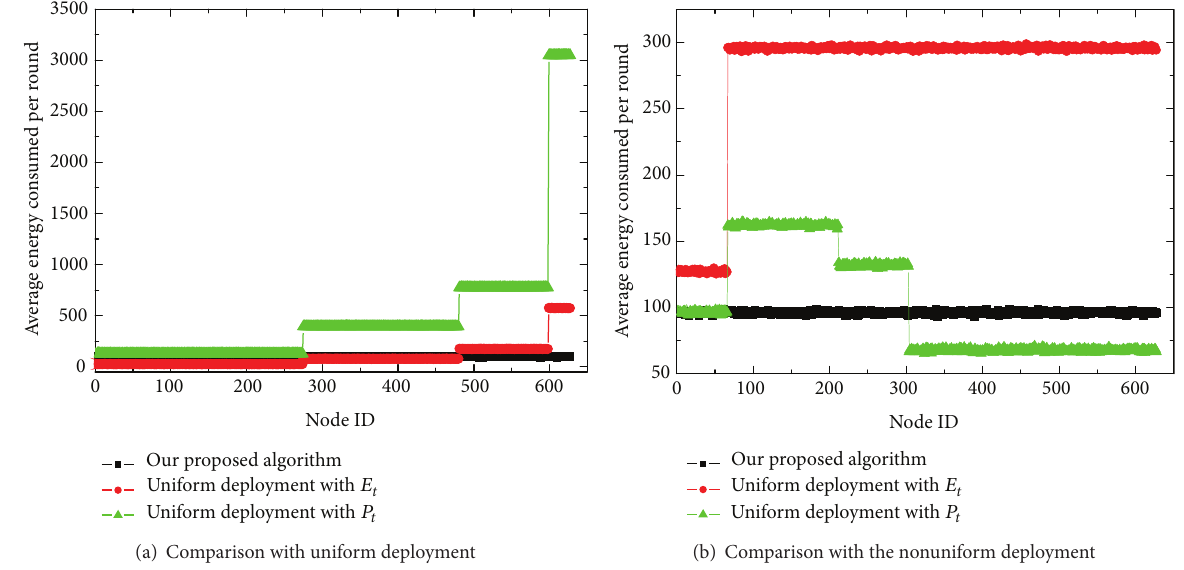
Figure 7: Comparison of average energy consumption in a sampling period.